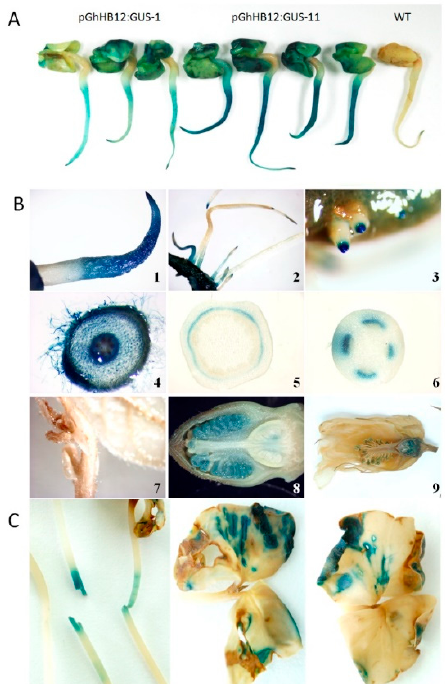
Figure 2. Histochemical localization of β -glucuronidase (GUS) activity in pGhHB12:GUS cotton plants. ( A ) GhHB12 promoter drives GUS expression in the cotyledons and primary roots of the 3-day-old seedlings. ( B ) GhHB12 promoter preferentially drives GUS expression in cotton primary roots, tips of lateral roots, vascular tissues, and floral organ. GUS staining in the ( 1 ) primary roots and ( 4 ) root hairs of the 3-day-old seedlings, ( 2,3 ) lateral roots of the 10-day-old seedlings, ( 5 ) section of stem, ( 6 ) petiole, ( 7 ) shoot apices and young leaves of 30-day-old plants, a longitudinal section of ( 8 ) buds and ( 9 ) flowers. ( C ) Wounding stress regulation of GhHB12 promoters. GUS activity was detected in the mechanically damaged hypocotyls and cotyledons of the 10-day-old seedlings.